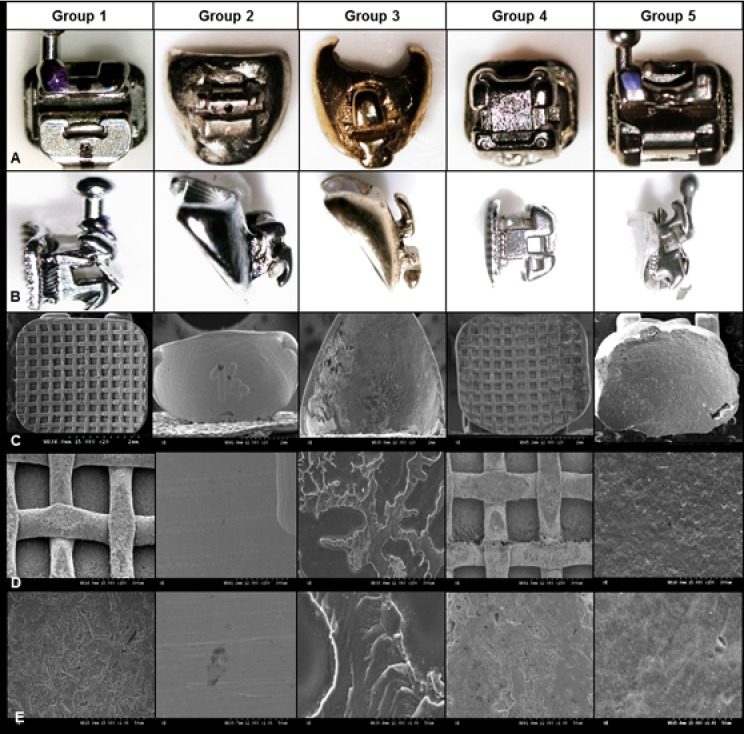
Stereo microscope and SEM imagines of bracket specimens.Stereo microscopic frontal and lateral imagines of bracket specimens and scanning electron microscopy imagines of bracket bases. A. Frontal view; B. Lateral view; C. Bracket bases (20×); D. Bracket bases (150×); E. Bracket bases (1000×). Group 1, preadjusted bracket; Group 2, Harmony; Group 3, Incognito; Group 4, Insignia; Group 5, Orapix.